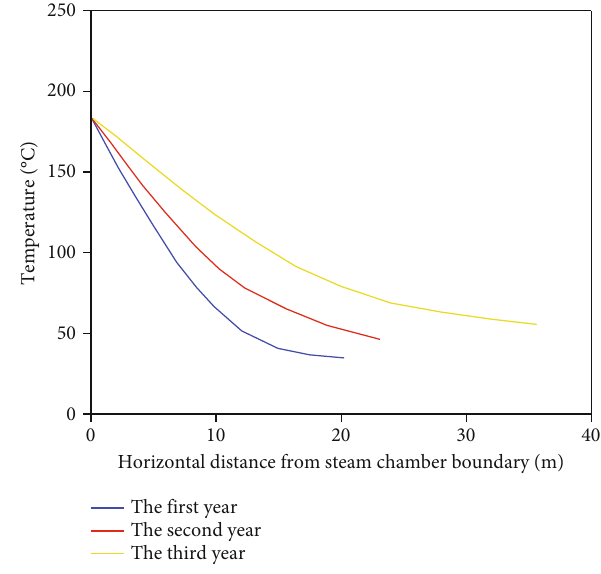
Figure 7: Schematic of temperature distribution at the edge of the steam